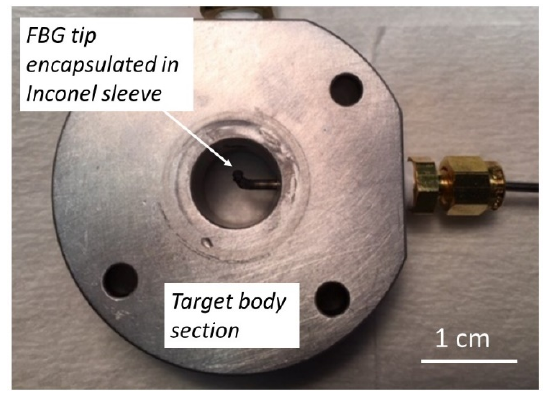
Figure 8. FBG-based temperature probe inserted in the target body after irradiation in an empty target cavity. The damaged tip can be seen in the center of the target.